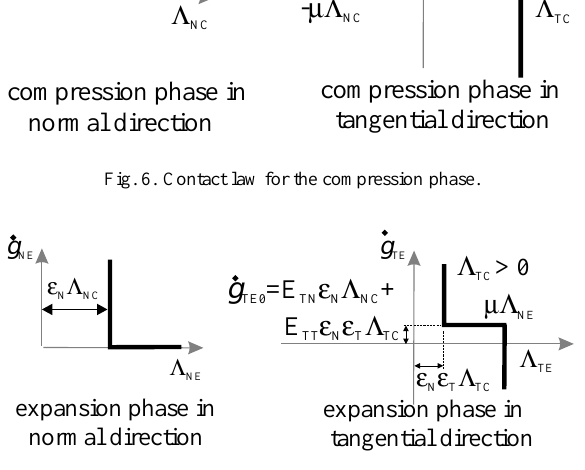
Fig. 7. Contact law for the expanssion